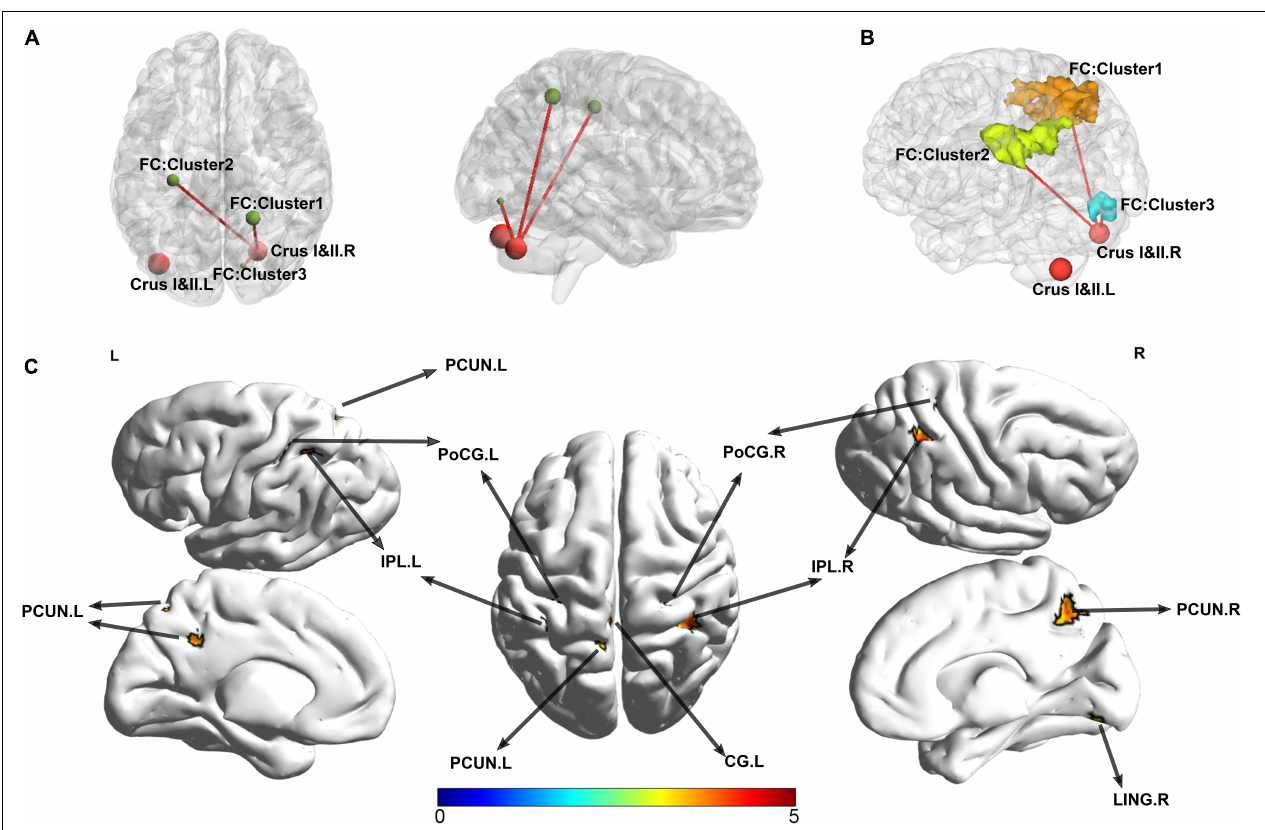
FIGURE 3 | Abnormal functional connectivity patterns in patients with SSD. The surviving clusters in SUIT-VBM were defined as ROIs; FC between the clusters and the whole-brain voxels was calculated in the patients with SSD and HC. (A) The significant FCs were presented visually by BrainNet Viewer, sagittal and axial view, respectively. (B) The shapes and spatial relationships of all three surviving clusters were outlined in a three-dimensional space. Clusters were labeled with different colors. (C) The lateral, medial, and dorsal view of the volume to surface mapping. PCUN, precuneus; IPL, inferior parietal lobule; CG, cingulate gyrus;